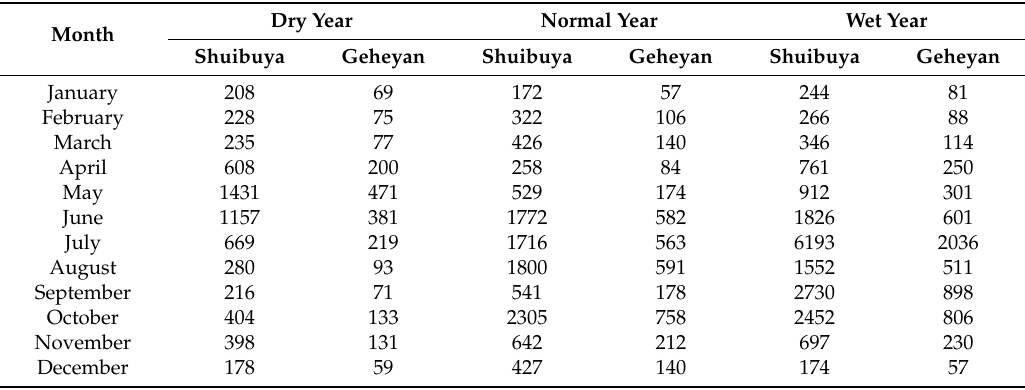
Table 2. Typical runoff data for each month in the wet, normal, and dry years (m 3 /s).